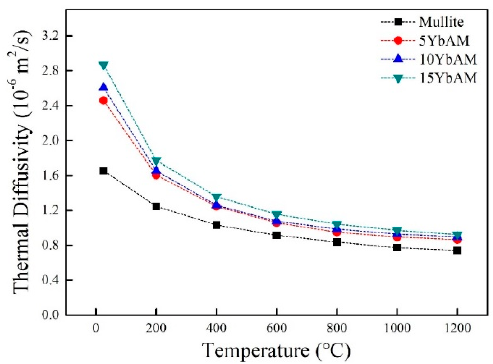
Figure 7. Thermal diffusivity of samples as a function of temperature.